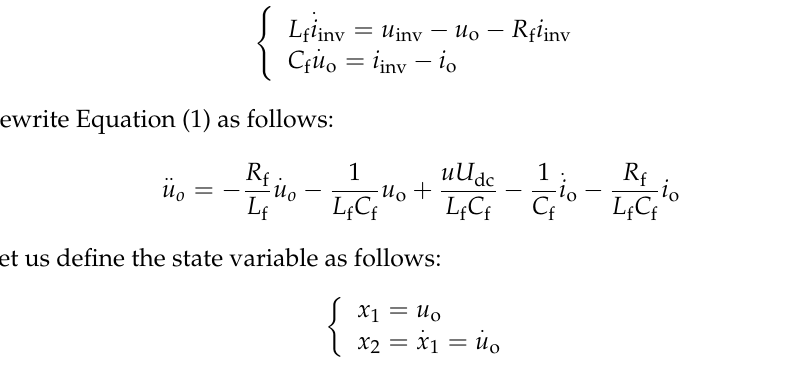
is the inductor current on the inverter side. inv